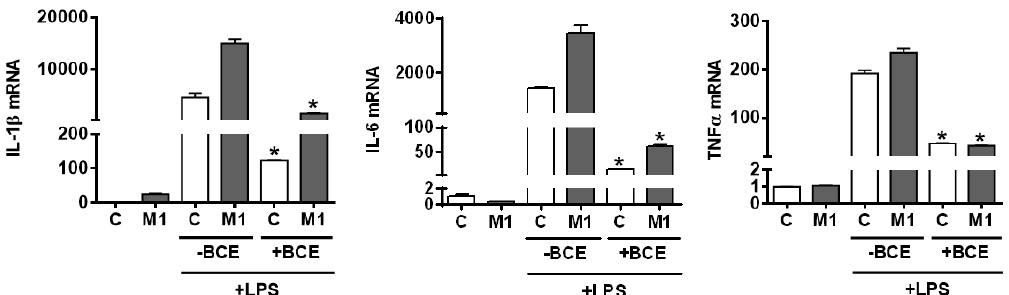
Figure 4. Expression of pro-inflammatory genes upon lipopolysaccharide (LPS) stimulation in M1 polarized mouse bone marrow-derived macrophages (BMDM). BMDM were polarized to M1 using interferon γ (IFNγ) and tumor necrosis factor α (TNFα) (10 ng/mL each) with or without 50 µg/mL of blackcurrant extract (BCE) for 24 h, followed by stimulation with 10 ng/mL of LPS for 3 h. Data are shown as mean ± SEM. *, p < 0.05 vs. respective no BCE control.